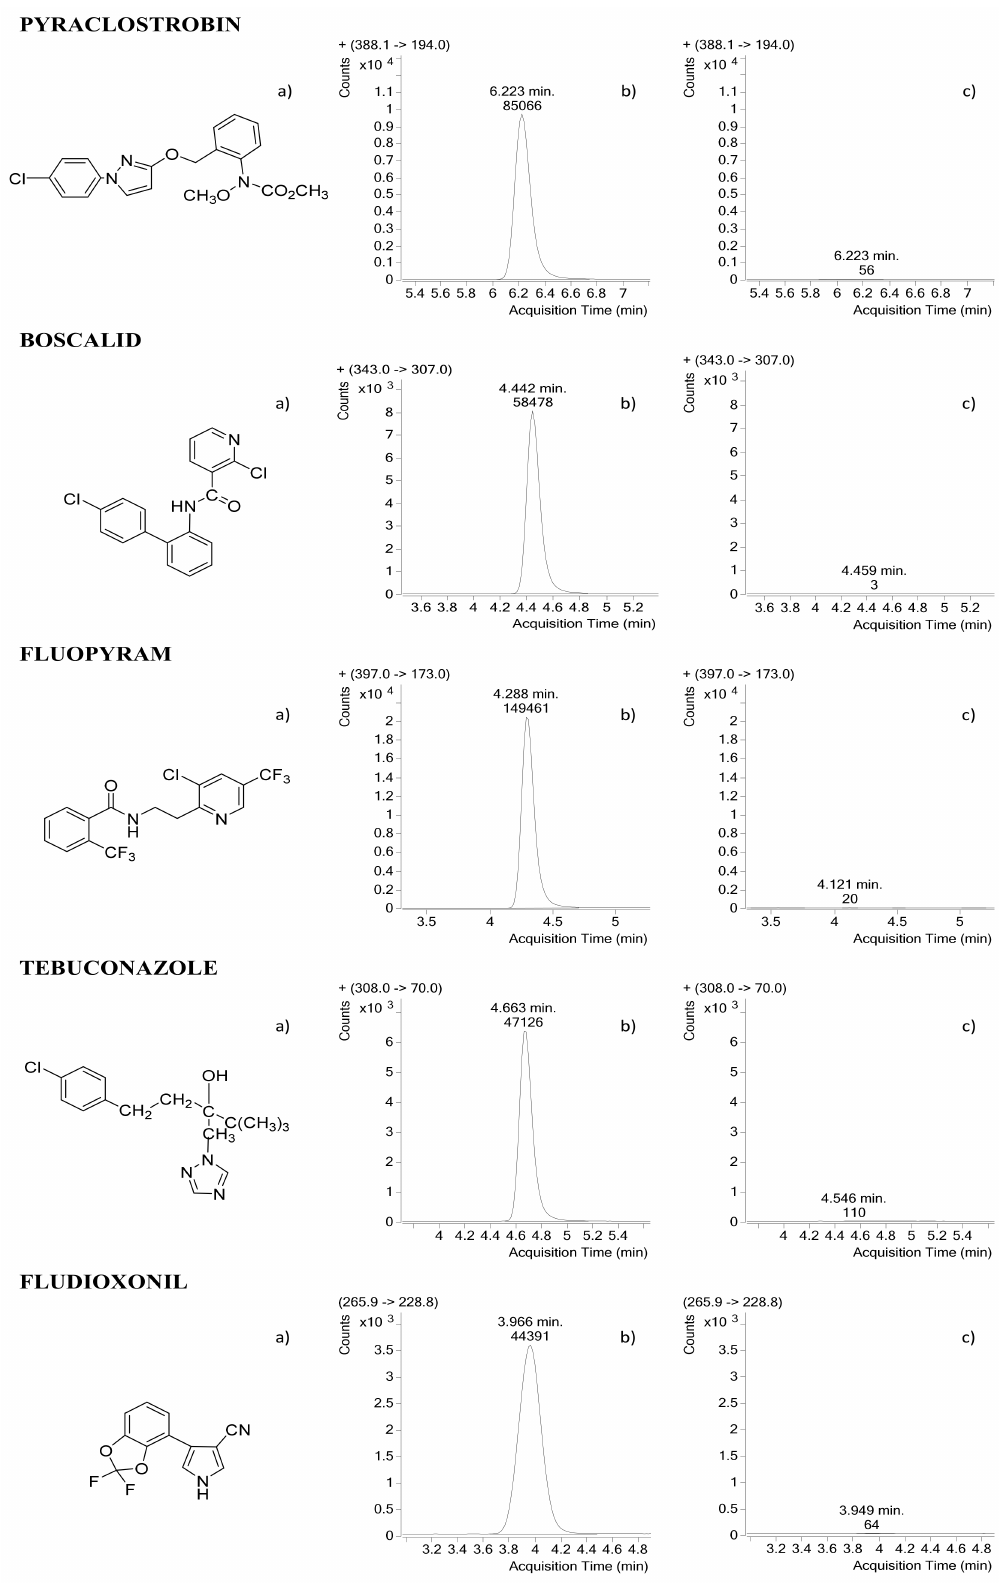
Figure 1. Chemical structures ( a ) and LC-MS/MS chromatograms (quantifier transitions) of the pesticides studied in blank persimmon samples ( b ) and at harvest ( c